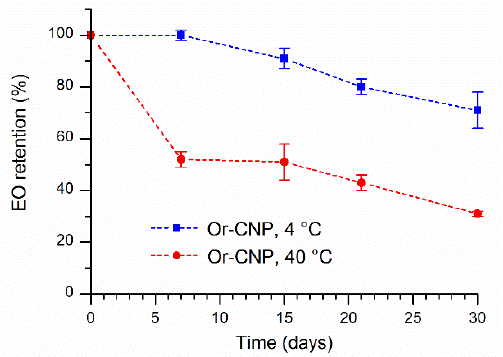
Figure 5. Essential oil retention over time at 4 °C (square) and 40 °C (circle) for Or-CNPs.